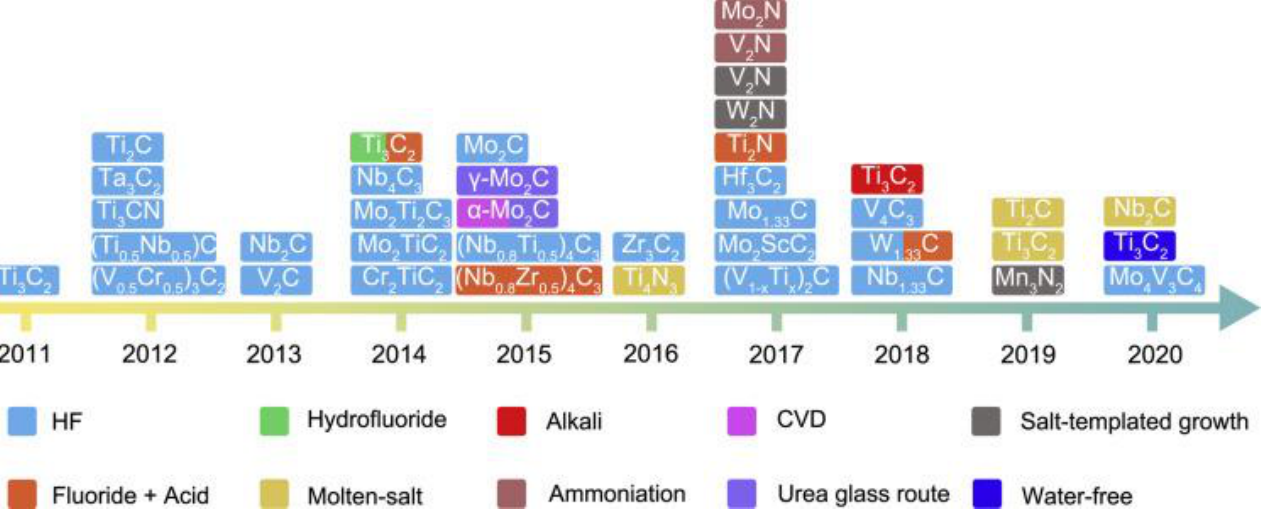
Figure 4. Timeline of a typical synthetic route for MXene in the past decade. Adapted with permis- sion [13]. Copyright 2021, Elsevier.